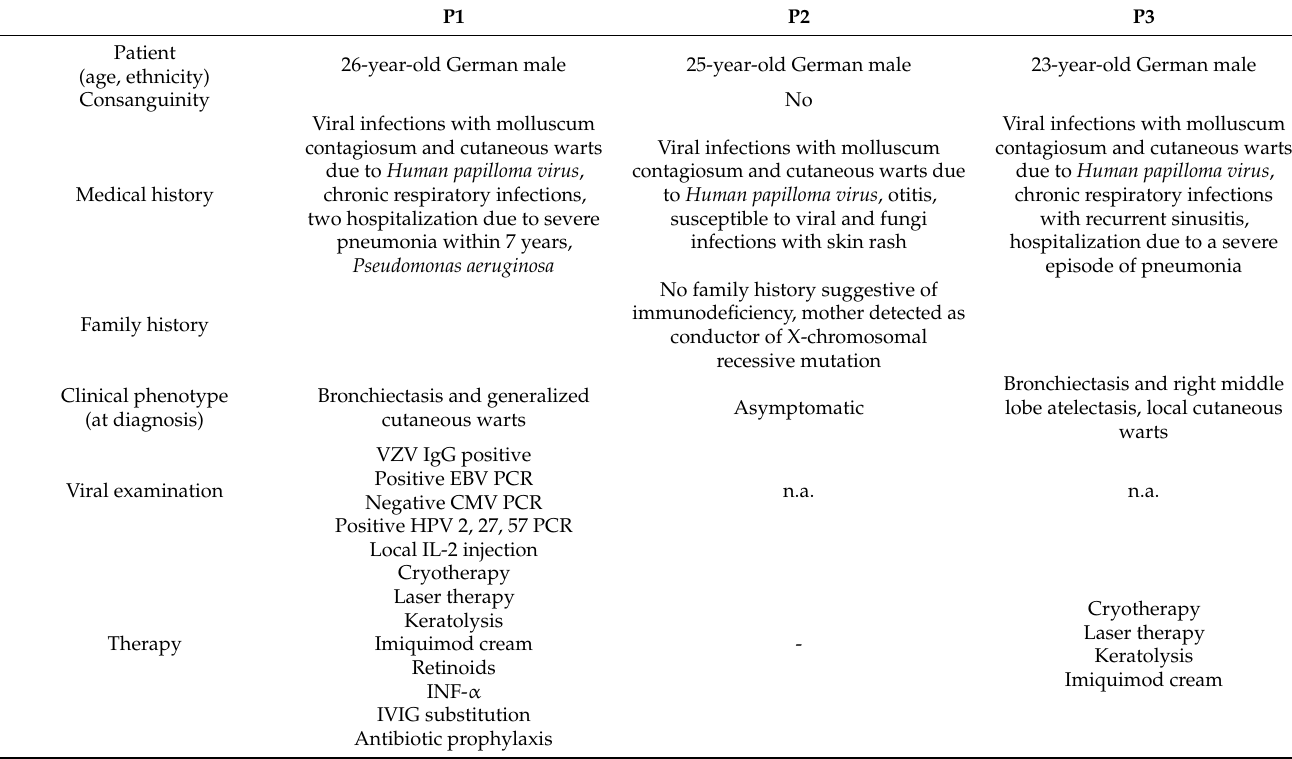
Table 1. Clinical history of reported